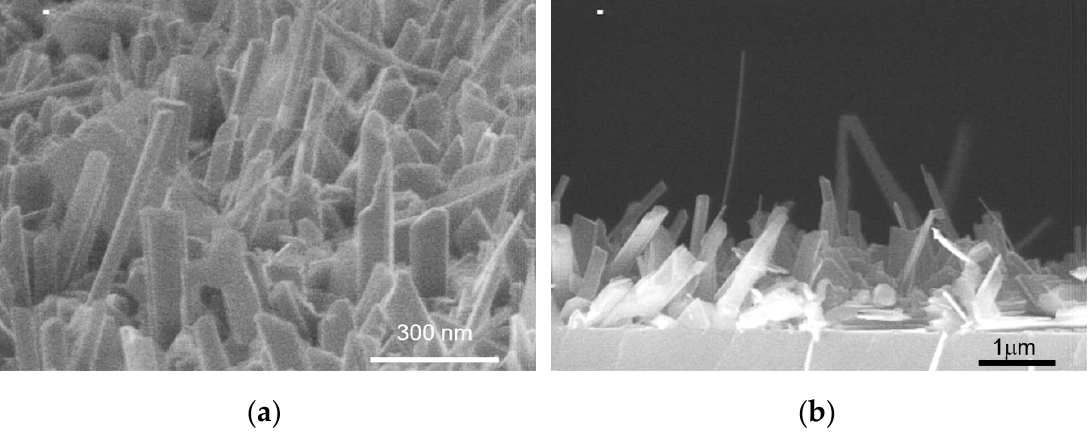
Figure 8. The plan-view ( a ) and cross-section ( b ) SEM images of the InSe / GaAs(001) film (sample # IS1 ) grown at T S = 450 °C at nearly stoichiometric growth conditions.